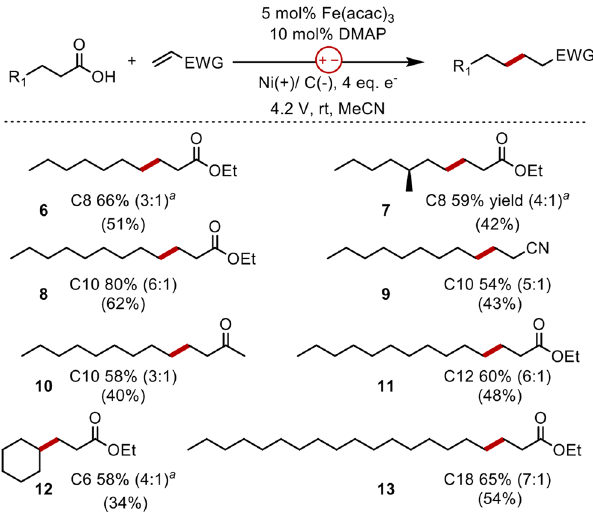
Fig. 5 Substrate scope. Scope of electrochemical decarboxylation. The ratio represents the yield of the addition product to the sum of all other isomers. Isolated yields are reported in parenthesis. a RVC used in place of Ni foam.